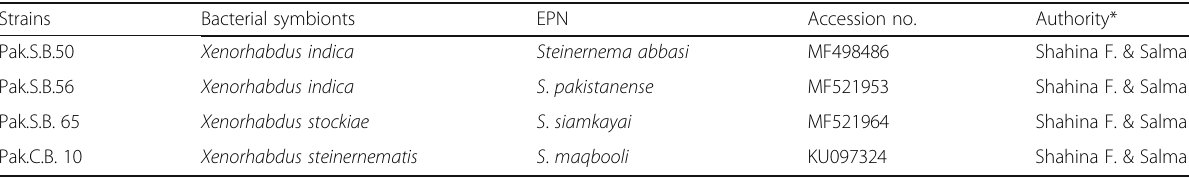
Table 1 Details of symbiotic bacteria used for the study